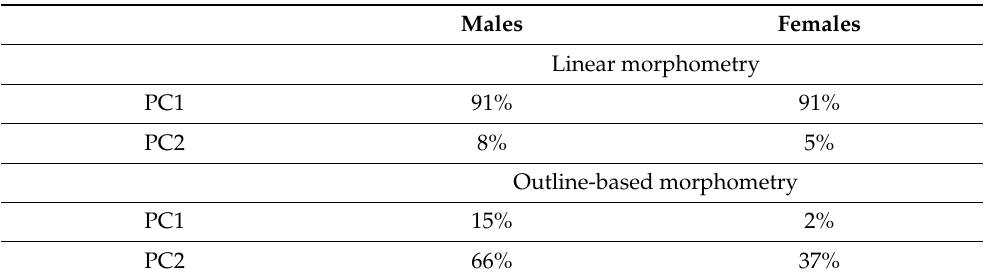
Table 3. Estimated influence of size variation on shape variables in males and females (the allometric effect) for linear and outline-based